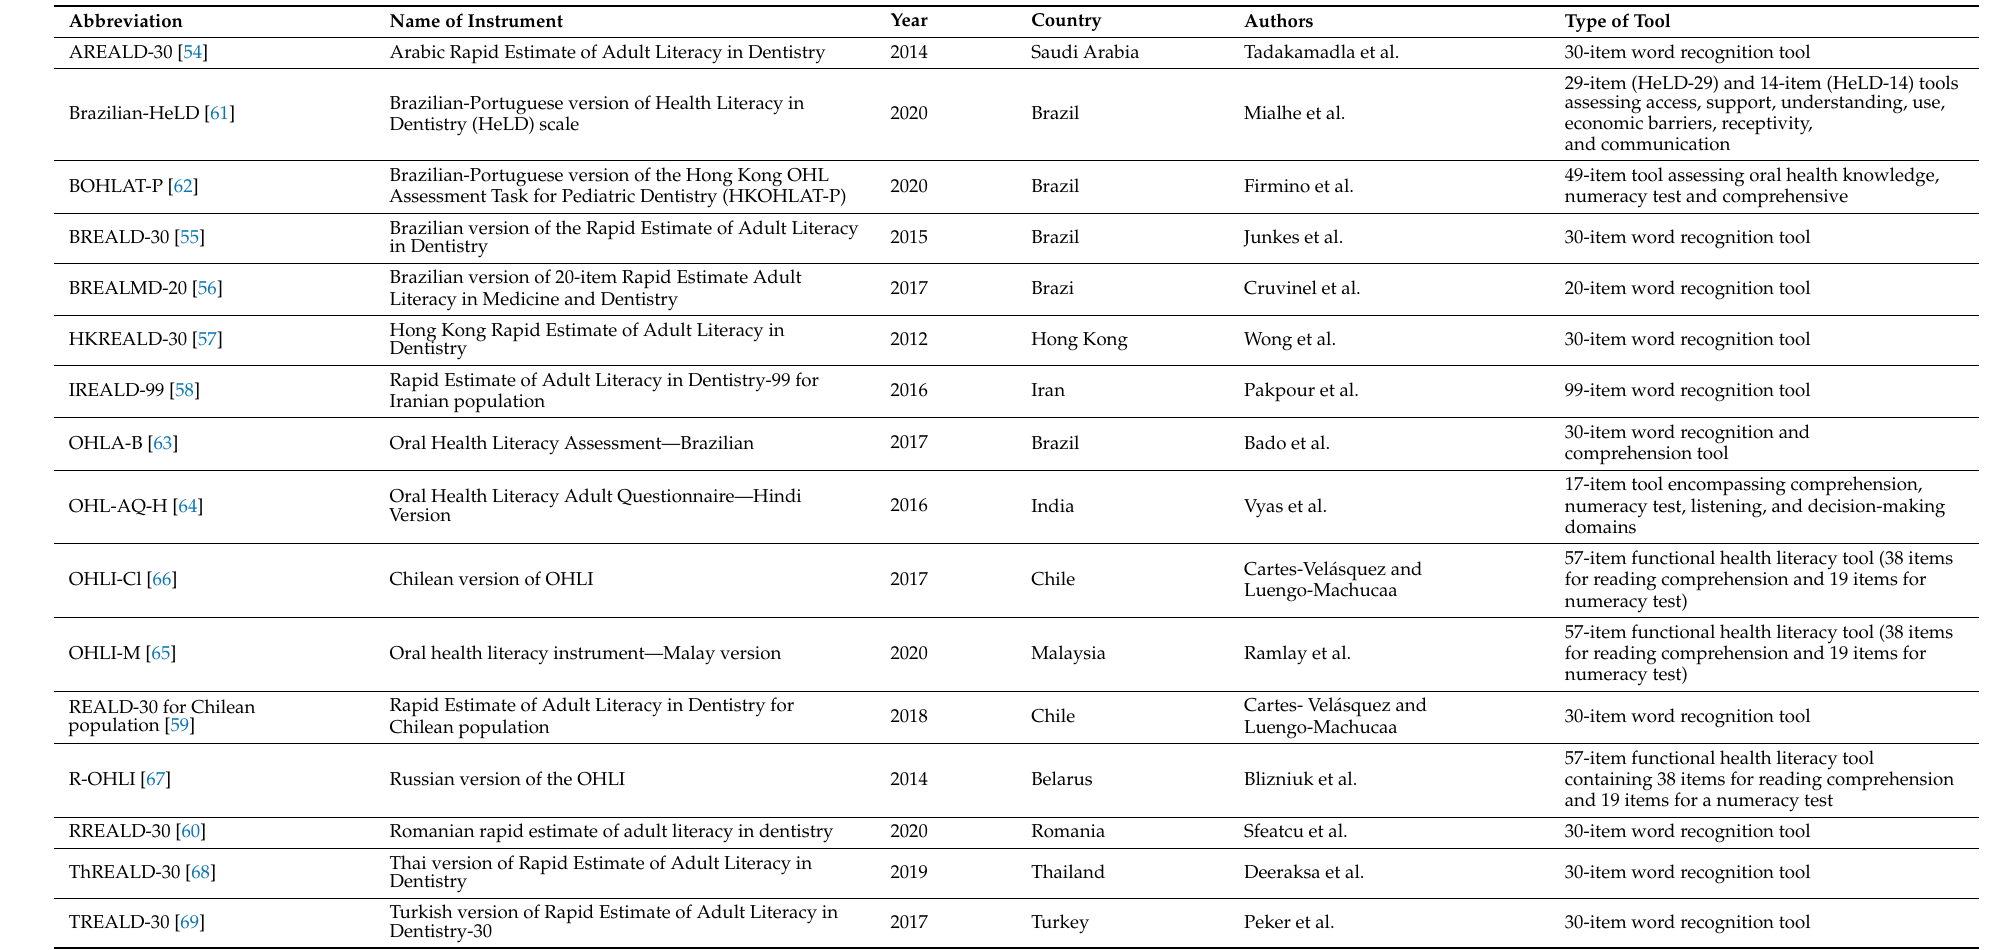
Table 1. Overview of OHL